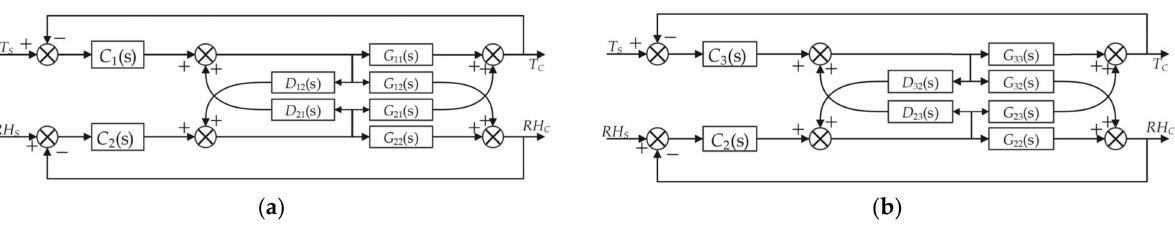
Figure 4. ( a ) The heating-humidifying decoupling control block diagram, ( b ) the cooling-humidifying decoupling control block